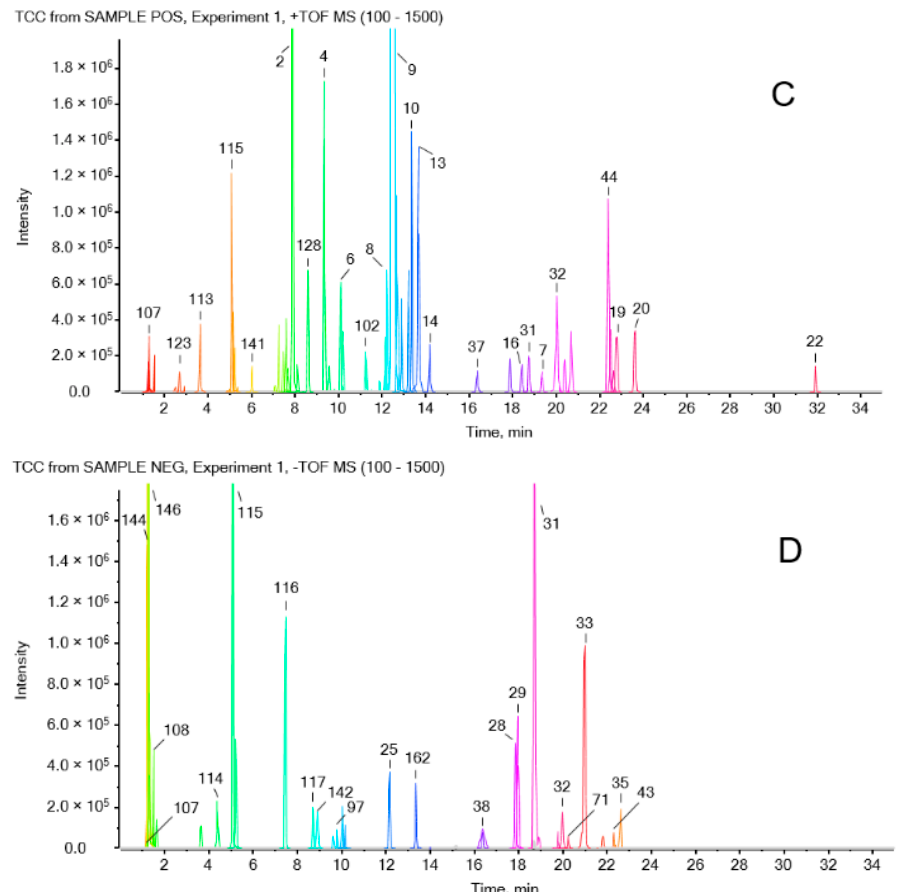
Figure 1. BPC of Wu-Zhu-Yu decoction in ( A ) positive and ( B ) negative ion modes by LC-QTOF MS, and TCC in ( C ) positive and ( D ) negative ion modes. The labels of the TCC peaks were all corresponding to the compound numbers in Table S1.